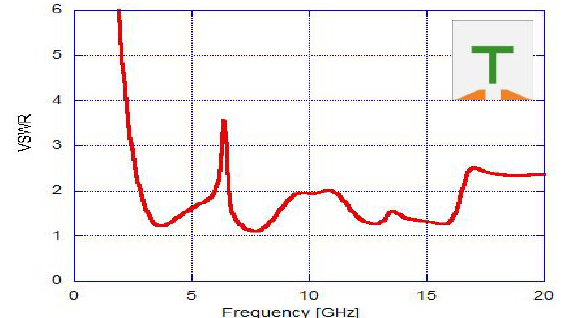
Figure 5: Simulated VSWR of the proposed antenna with the T-shaped parasitic strip.